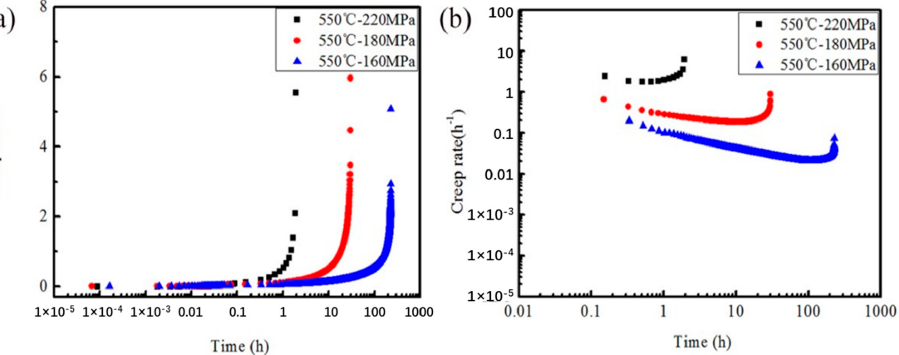
Figure 5. Creep curves of TLP joints for different stresses: ( a ) relationship between creep strain and time; ( b ) relationship been creep rate and time.